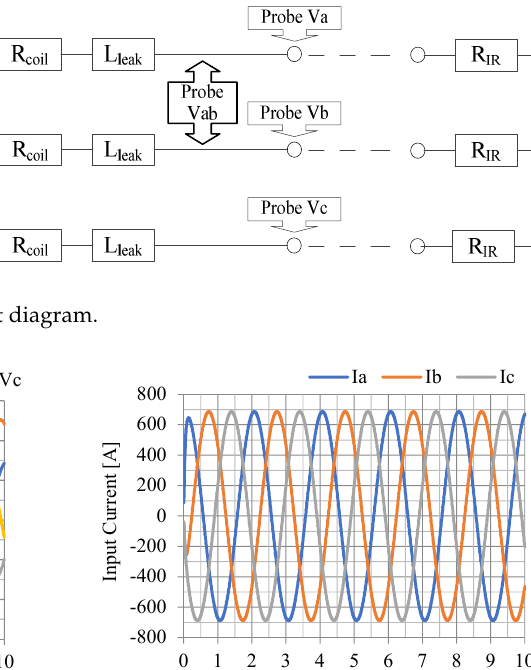
Table 4. Characteristics in power generation mode.